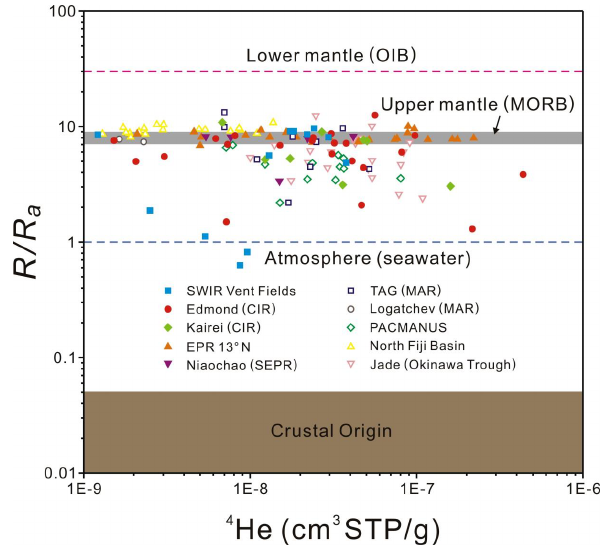
Figure 3. Figure 3. Scatter plots of R/R a versus 4 He concentrations in polymetallic massive sulphides from active or inactive hydrothermal systems along the SWIR and CIR. Datapoints from other seafloor vent fields in different tectonic settings are also shown for comparison, given by [36,40–46,100–102].